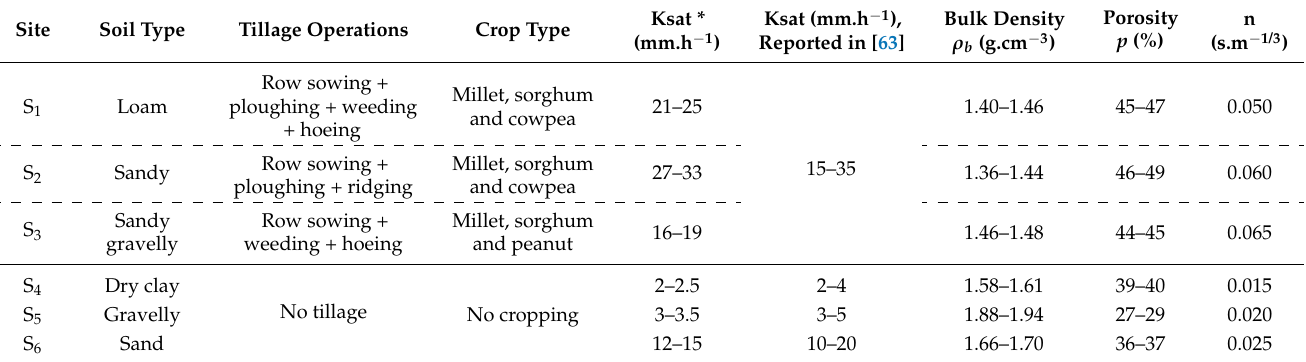
Table 2. Physical properties of the soil on the monitoring sites in the Tougou